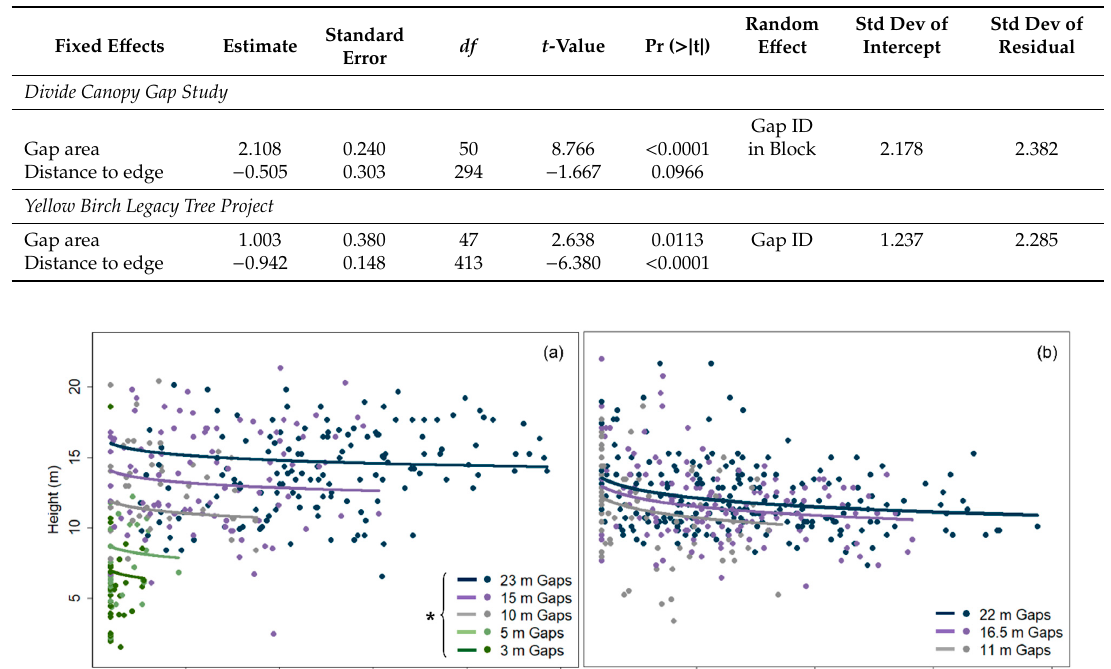
Table3. Linearmixed-e ff ectsmodelresultsofgap-capturingsaplingheight(DCGS:23yearspost-harvest, YBLP: 15 years post-harvest) predicted by gap area and distance to gap edge from two group-selection study sites in northern hardwood forests of the upper Great Lakes, USA. Both distances to edge and gap areas were natural-log transformed (ln (x + 1)) to meet assumptions of linearity and homoscedasticity and to improve model fit.